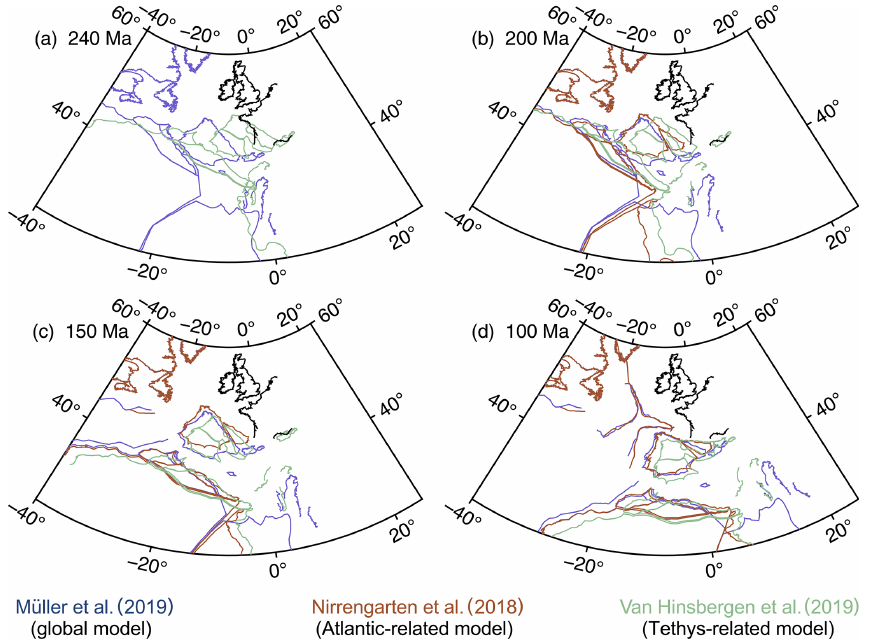
Figure 4. Compilation of previous global (Müller et al., 2018), Atlantic-related (Nirrengarten et al., 2018), or Tethys-related (Van Hinsbergen et al., 2020) kinematics reconstructions used in our reconstruction, at 240Ma (a) , 200Ma (b) , 150Ma (c) , and 100Ma (d) . Note that the Nirrengarten et al. (2018) reconstruction is not shown at 240Ma as it is not represented in the original